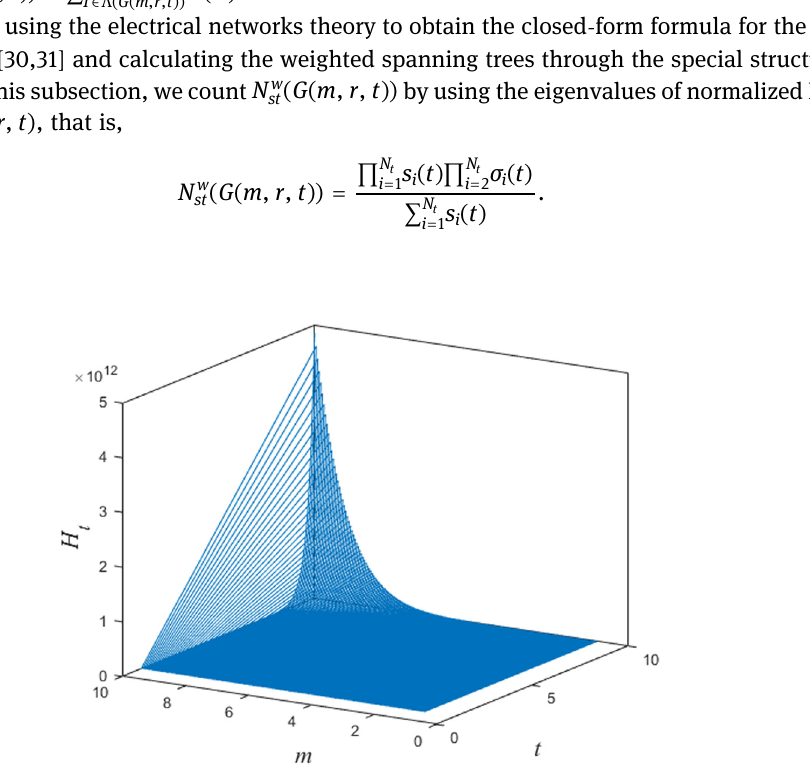
Figure 3: Random target access time H t of ( ) G m r t , ,